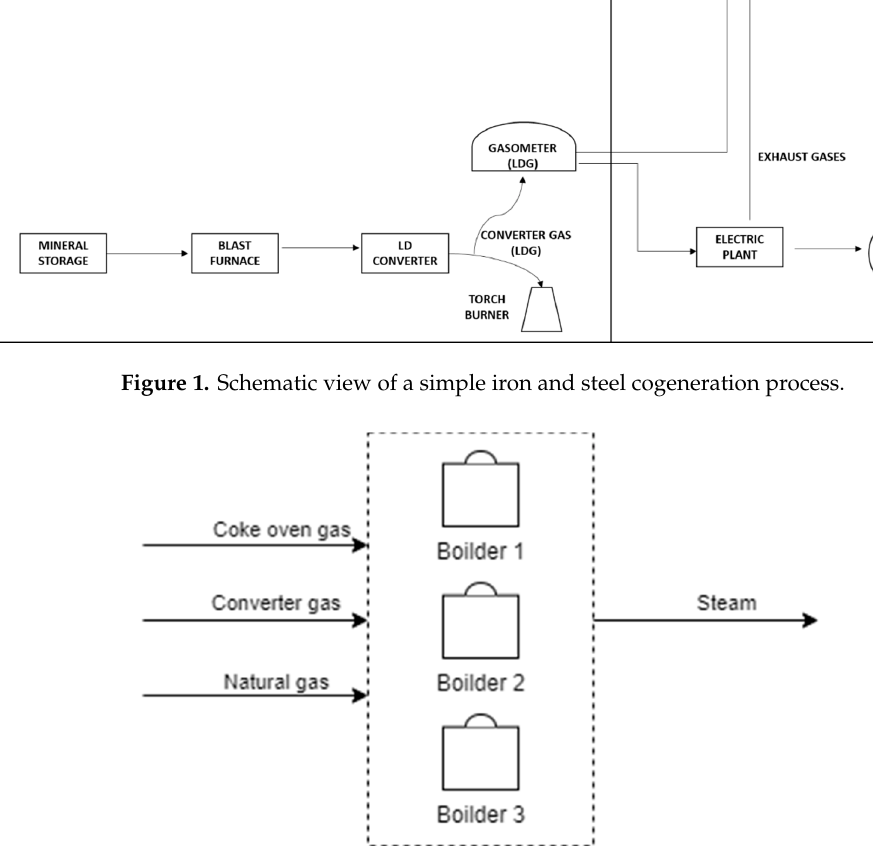
Figure 1. Schematic view of a simple iron and steel cogeneration process.